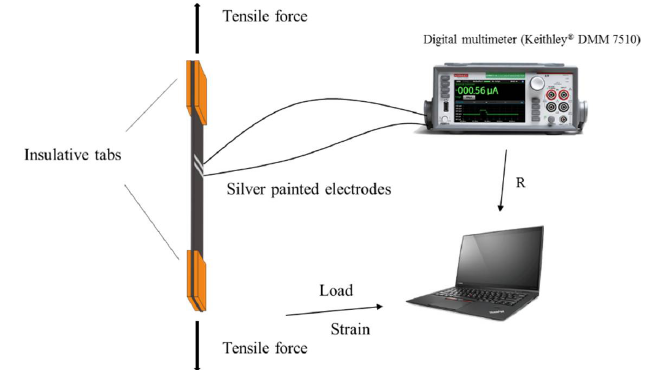
Figure 6. Experimental setup of quasi-static tensile test with simultaneous measurement of resistance change in a local